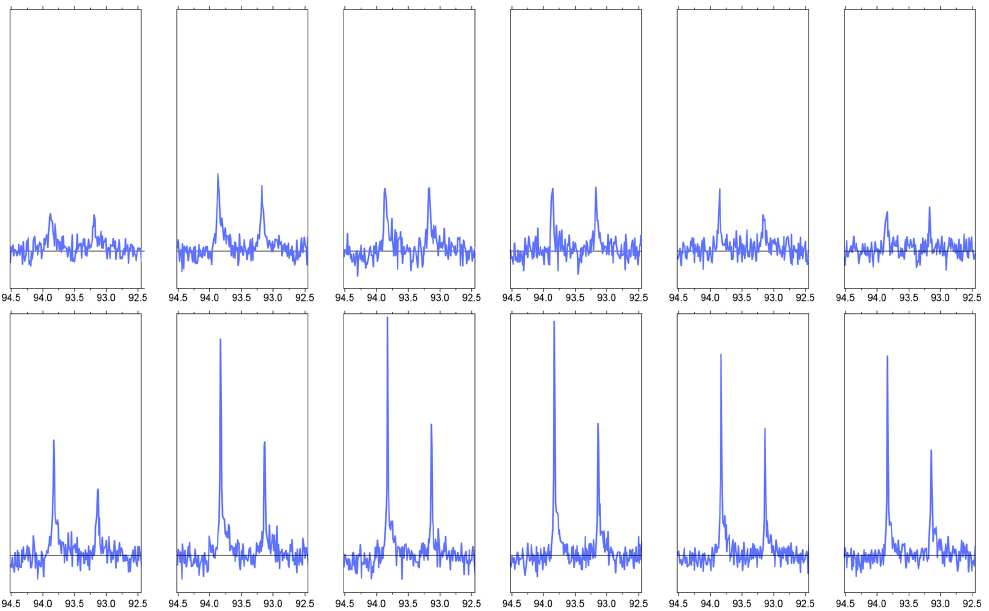
Figure B1. The first six NMR spectra of hyperpolarized 1- 13 C pyruvate in aqueous solution, recorded during two consecutive experiments (top and bottom rows). Compared to the experiment shown in Fig. 3, the spectra were recorded with a reduced receiver gain. Only the spectral region corresponding to the carbonyl 13 C of pyruvate hydrate is shown. For the experiments shown here, the sample tube is evacuated prior to solvent injection. Furthermore, the delay for settling (i.e., prior to the column labeled NMR in Fig. C1) is increased from 100 to 350ms, so that the total time from sample ejection to the beginning of acquisition is 2s. In the first experiment (top row), the polarization is low because the microwave irradiation frequency was not set correctly. In the second experiment, the microwave frequency was corrected. For the second dataset, the linewidth (FWHM) is 3.9(2)Hz in the first spectrum, 2.4(0)Hz in the second, and 2.1 ± 0.3Hz in the subsequent spectra. The injection device was not removed from the magnet between the two